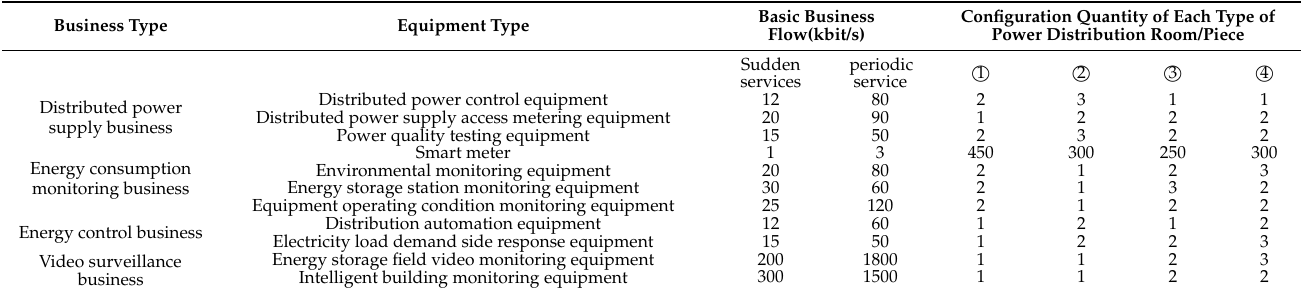
Table 2. The actual configuration of four types of intelligent distribution rooms in a smart